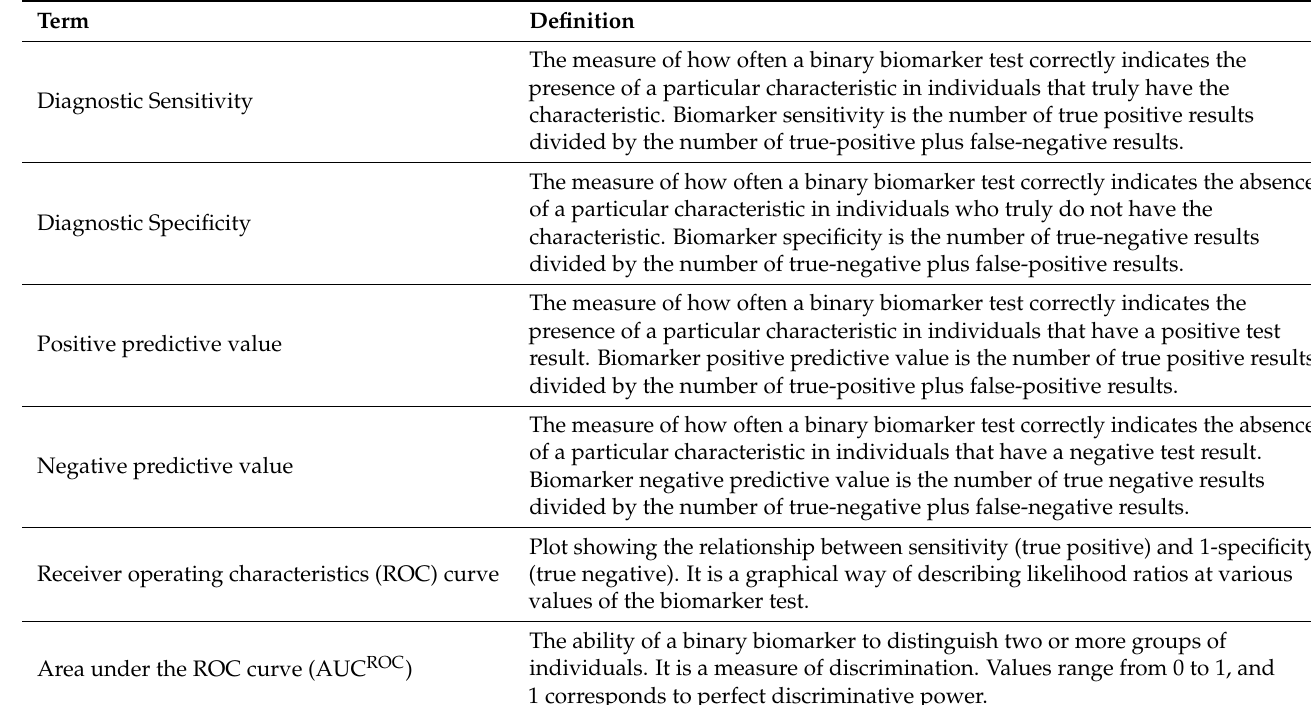
Table 5. Definitions of terms assessed in clinical validation, according to References